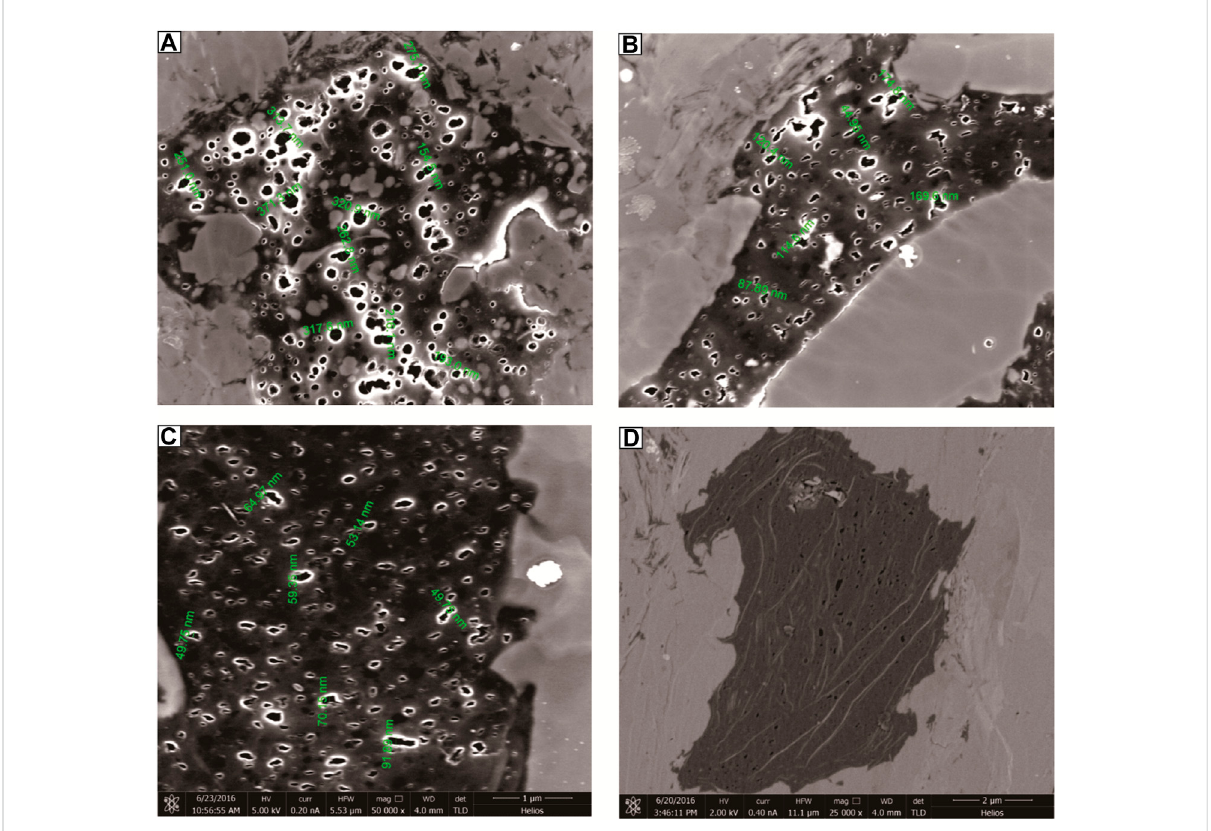
FIGURE 6 Development characteristics of organic micro-pores in the dark shale of the Wufeng − Longmaxi Formation in the Wuxi area. (A) Gray black shale,X202(1888.99 m); (B) blackcarbonaceousshale,X202(1955.85 m); (C) grayblacksiltyshale,X203(3,616.64 m); (D) blackcarbonaceousshale, X203 (3,634.83